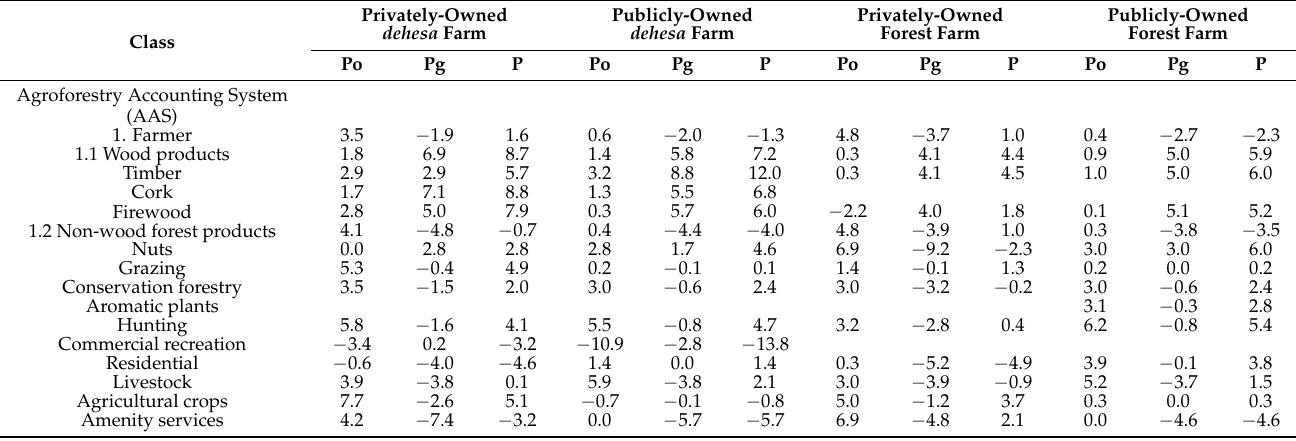
Table 8. Profitability rates of the case-study large dehesa and forest farms in Andalusia under the AAS and rSNA (2010: %).